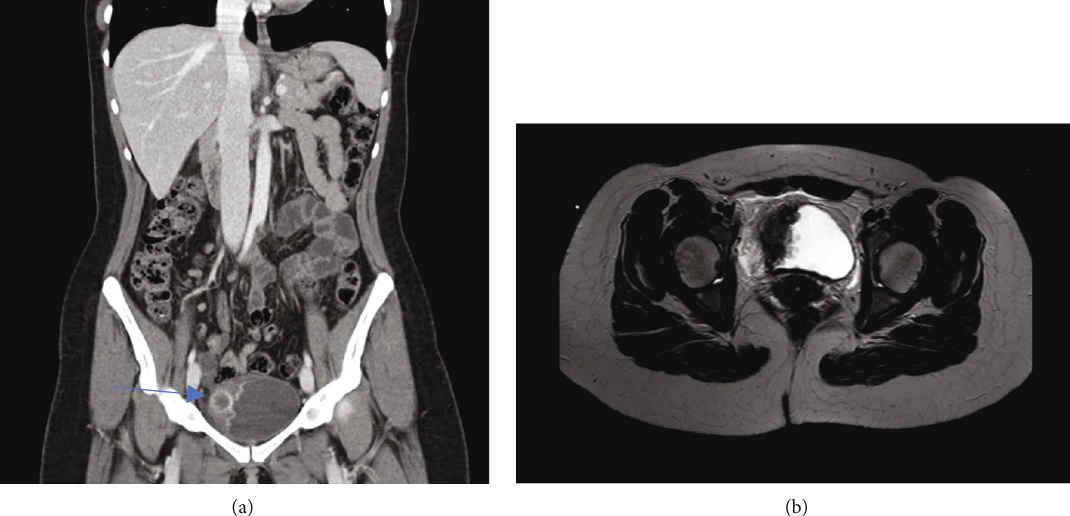
Figure 1: Coronal CT scan (a) and axial MRI (b) demonstrating 2 × 2 cm exophytic polyp (arrow) associated with signi fi cant bladder wall thickening of the urinary bladder with invasion of detrusor muscle.